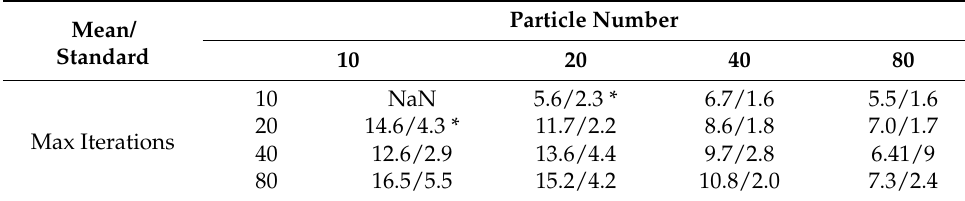
Table 7. Effect of expended iterations related to maximum iterations and particle